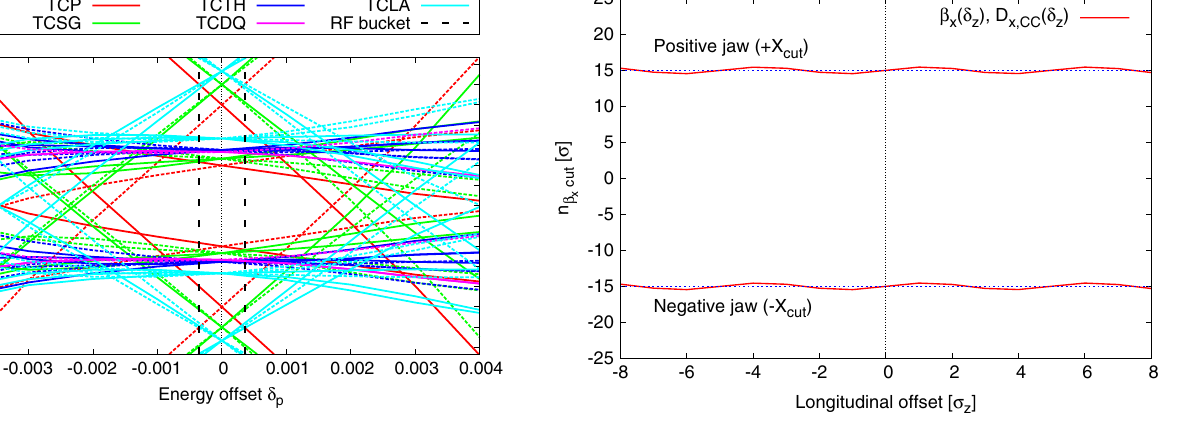
FIG. 7. (Color) Phase space cut from purely off-momentum beat, revealing the hierarchy of primary (TCP), secondary (TCSG), tertiary (TCTH), beam dump (TCDQ) horizontal colli- mators, and shower absorbers